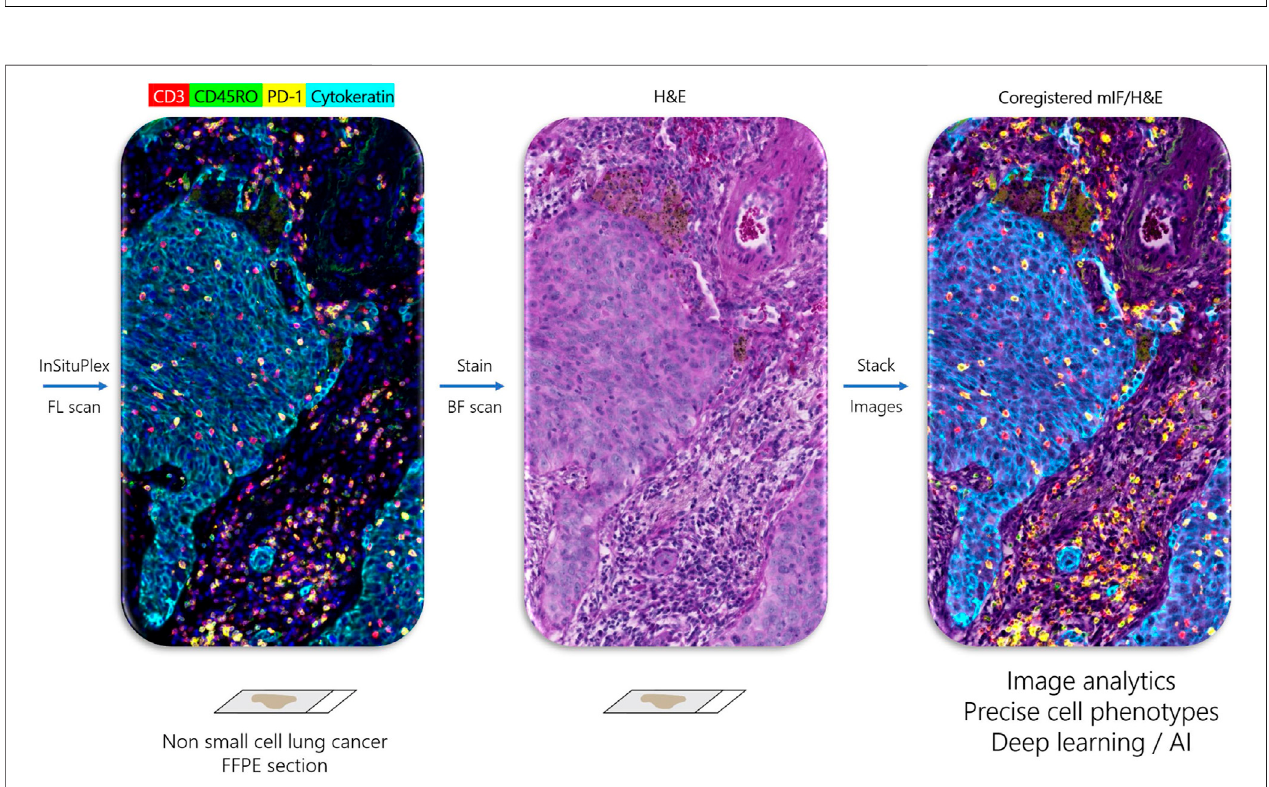
FIGURE 1 | Ultivue InSituPlex (ISP) assay work fl ow. (A , B) : Four different DNA-barcoded antibodies are applied to a FFPE tissue section. (B , C) : Barcode ampli fi cation. (D) : Targets are labeled through hybridization of fl uorescent probes to their respective barcodes. Higher plex staining (greater than 4-plex) is possible by initial application of all antibodies, each with a unique barcode, to the tissue and then detecting 4 markers per cycle, separated by gentle DNA exchange steps (not shown).